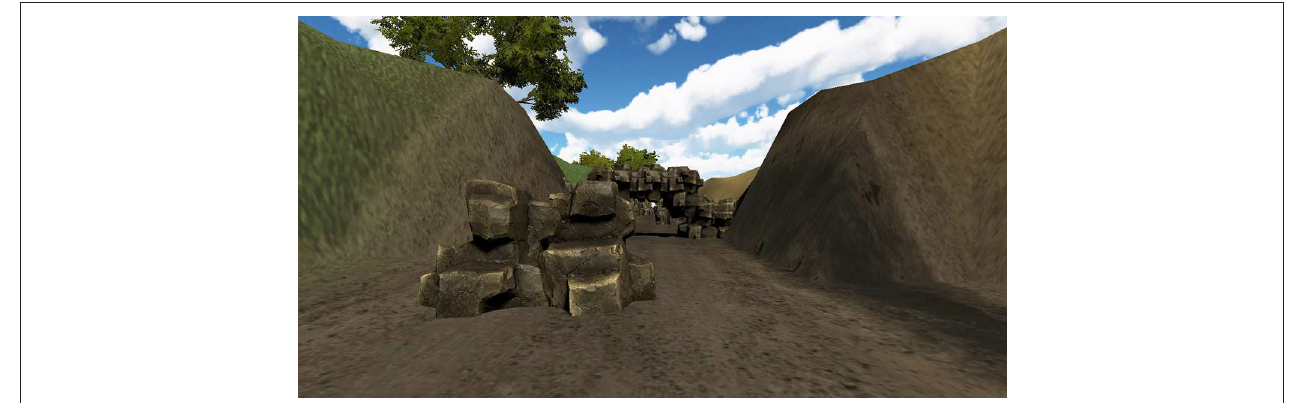
FIGURE 4 | A frame of the “Avoid the Rocks” environment.